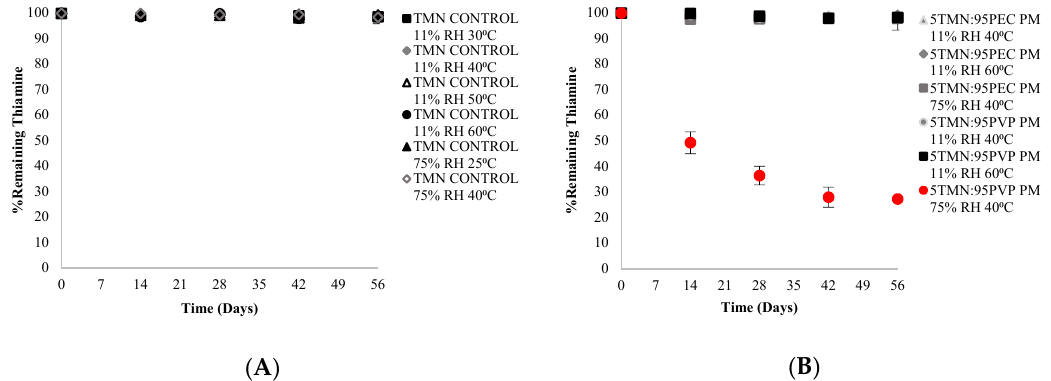
Figure 4. Chemical stability of thiamine ( A ) in pure crystalline TMN form, and ( B ) in 5TMN:95PEC and 5TMN:95PVP physical mixtures (PM).